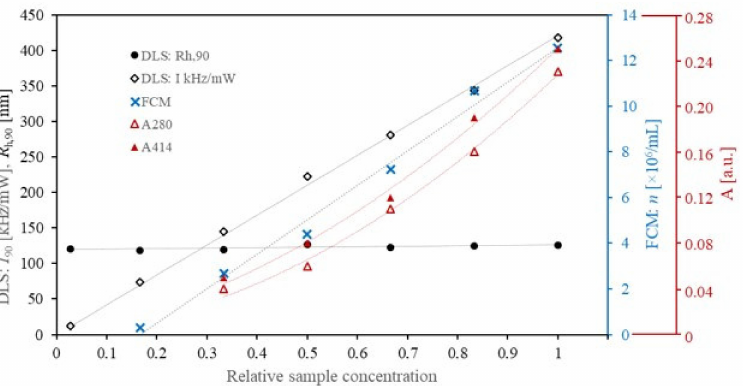
Figure A5. Results of light scattering, flow cytometry, and spectrophotometric analysis of serially diluted hbEVs samples. Average intensity of the scattered light I 90 (black rhombuses, scale on primary axis) and hydrodynamic radius R h,90 (black dots, scale on primary axis) extracted from the DLS analysis, count of events (blue crosses, scale on blue secondary axis) determined by FCM, and absorbance of the samples at 280 nm (A280, full red triangles) and A414 nm (A414, empty red triangles) (scale on red secondary axis). In FCM measurements, the concentration of the sample was adapted to the requirements of the equipment. As the absolute number of hbEVs in the sample cannot be defined by any of the employed methods, the abscise is expressed in relative units, where the highest concentration of hbEVs used in the experiment corresponds to the relative concentration